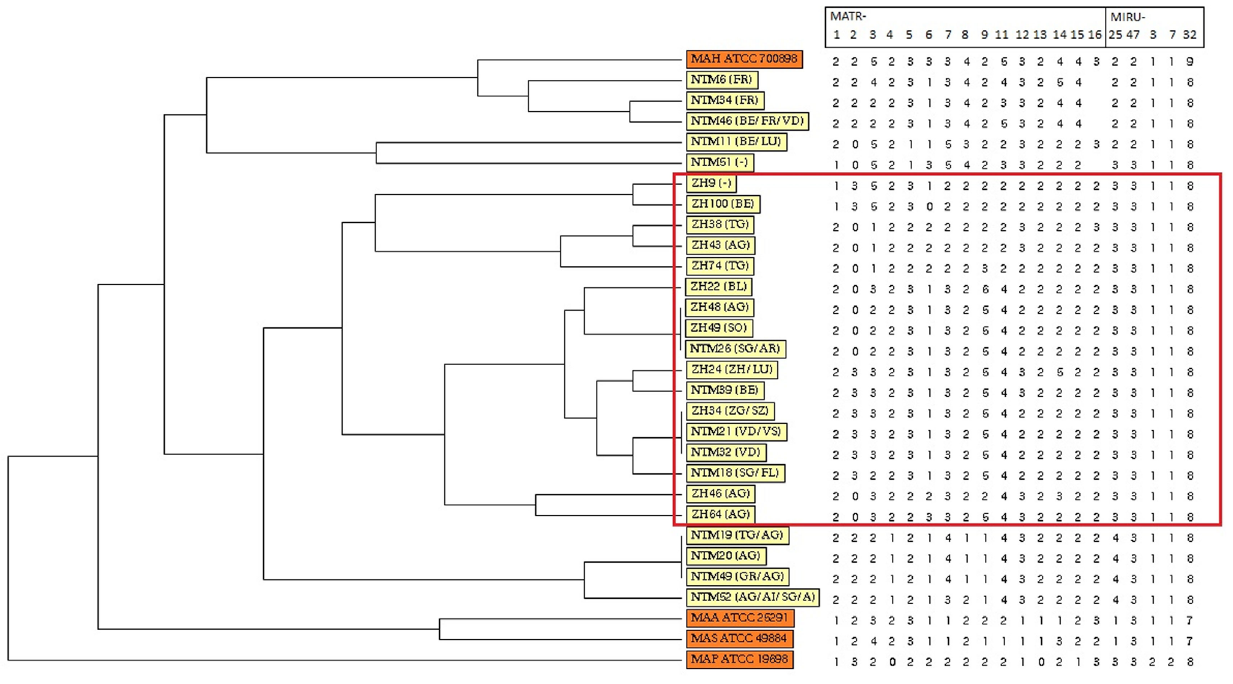
FigUre 1 | Dendrogram and allele profiles constructed from variable number of tandem repeat typing results of 26 Swiss Mycobacterium avium subsp. hominissuis (MAH) isolates including four reference strains. The dendrogram was generated with the unweighted pair group method using arithmetic average algorithm using tools available from the MIRU-VNTR plus database. Reference strains MAA ATCC 25291, MAS ATCC 49884, MAH ATCC 700898, and MAP ATCC 19698 are colored in orange, whereas all MAH isolates of this study are colored in yellow. The red box highlights a cluster of isolates from lymph nodes without any gross pathological changes of healthy, slaughtered cattle (group